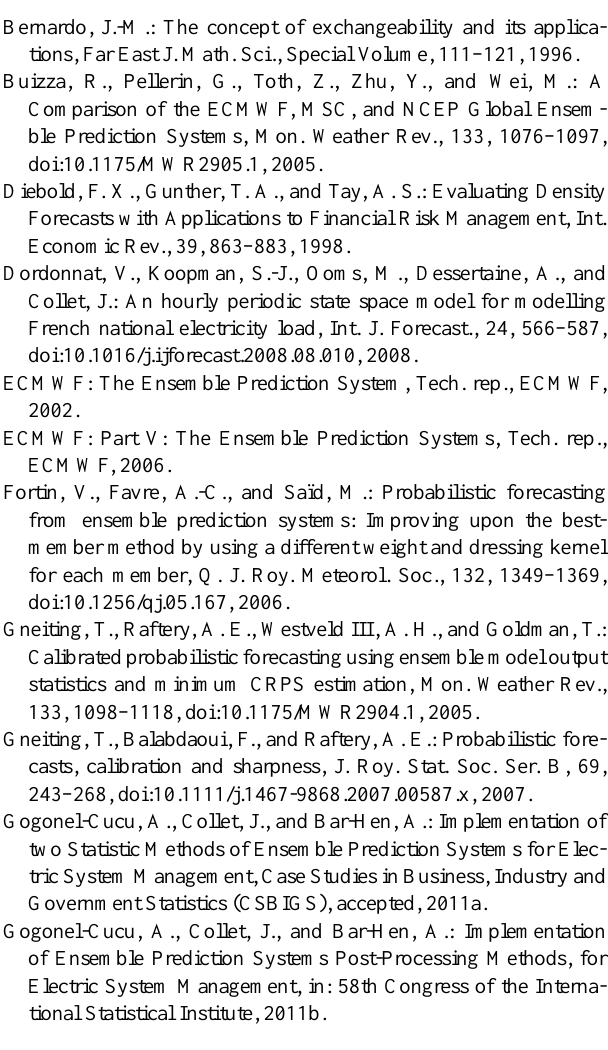
Fig. 6. Plot of χ 2 distances between theoretical and empirical distri- butions of Probability Integral Transform, with respect to horizon, for Best Member Method (BMM) and BMM with error modeling using quantile regression (BMM with QR).